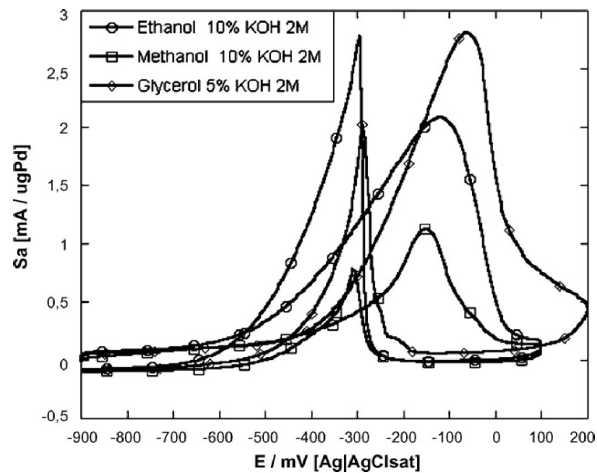
Figure 7. Cyclic voltammograms (at the fifth cycle) of methanol, ethanol and glycerol oxidation on a Pd/(multi-walled carbon nanotubes) electrode in 2 M KOH solution. Pd loading: 17 μ g cm − 2 . Scan rate: 50 mVs − 1 . Average size of Pd: 4.3 nm. Reprinted with permission from [116]. Copyright 2009